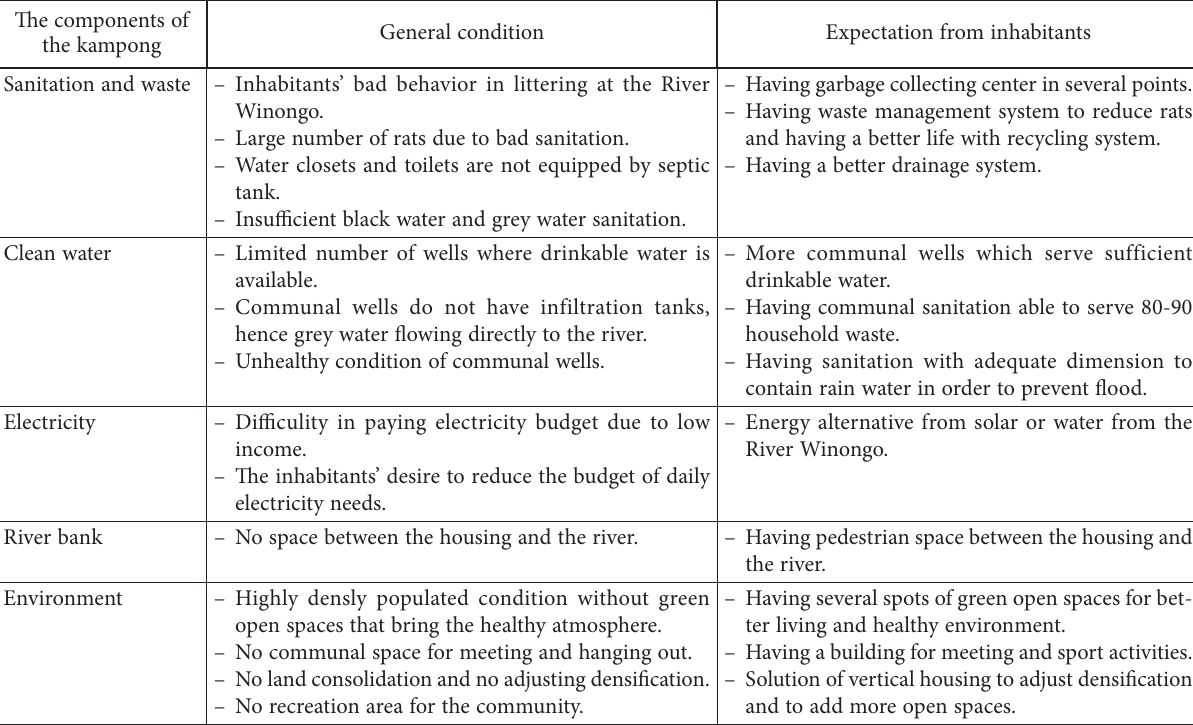
Table 2. Kampong conditions and expectation of inhabitant in kampong Gampingan-Pakuncen